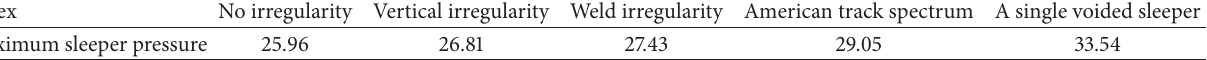
Table 2: Comparison of maximum sleeper pressures (kN).